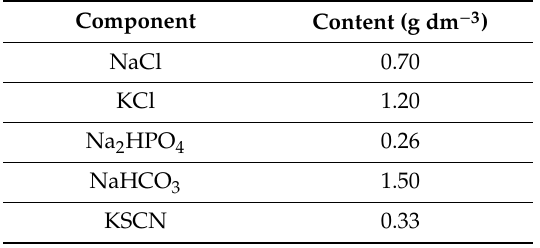
Table 5. Chemical composition of artificial saliva